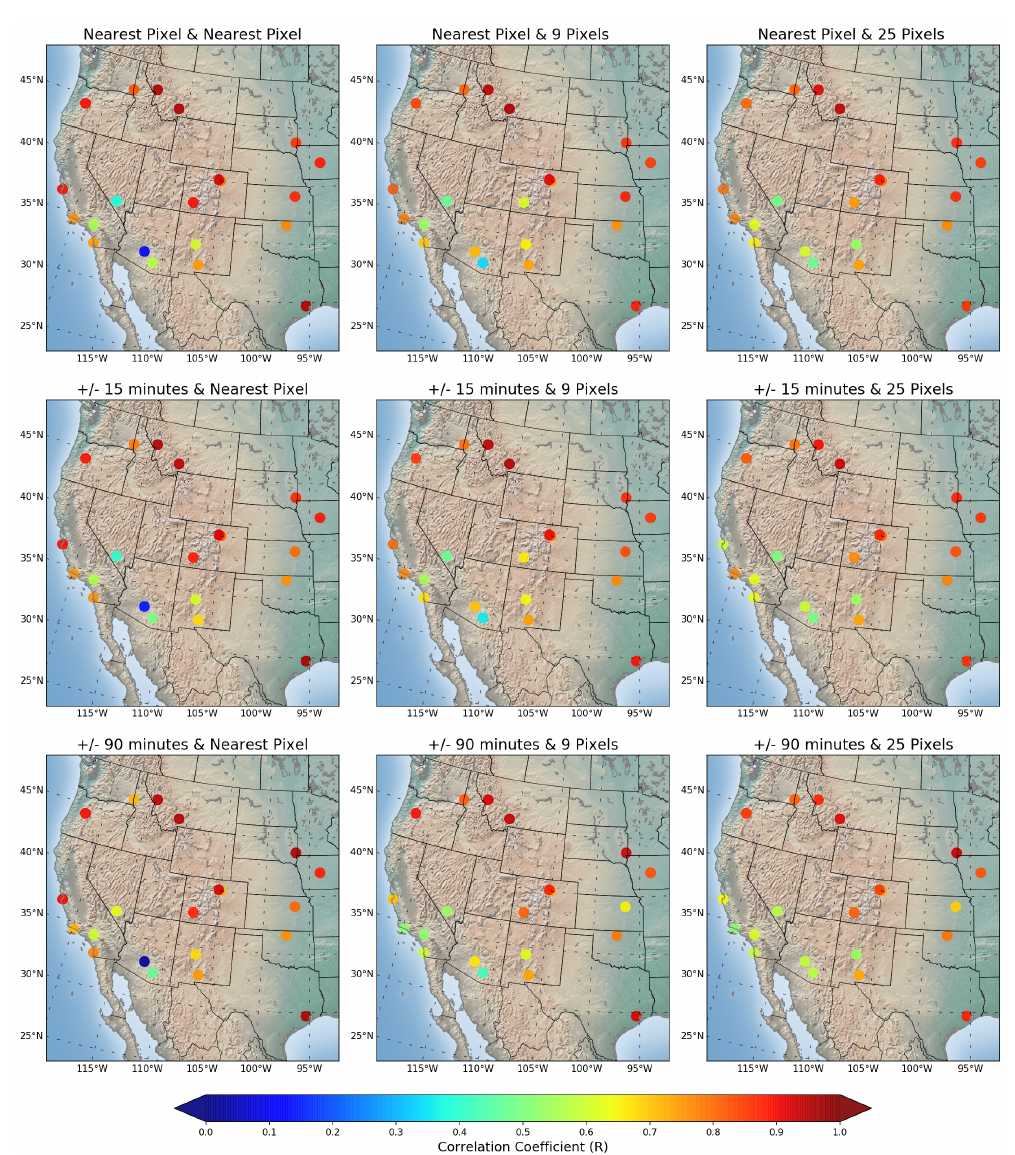
Figure 9. Pearson correlation coefficients between spatially aggregated at the nearest pixel, 30 km × 30 km box, and 50 km × 50 km box Aqua MODIS DT (Land and Ocean) AOD and temporally aggregated at the nearest ± 15 min and ± 90 min AERONET AOD at 23 AERONET sites across the western United